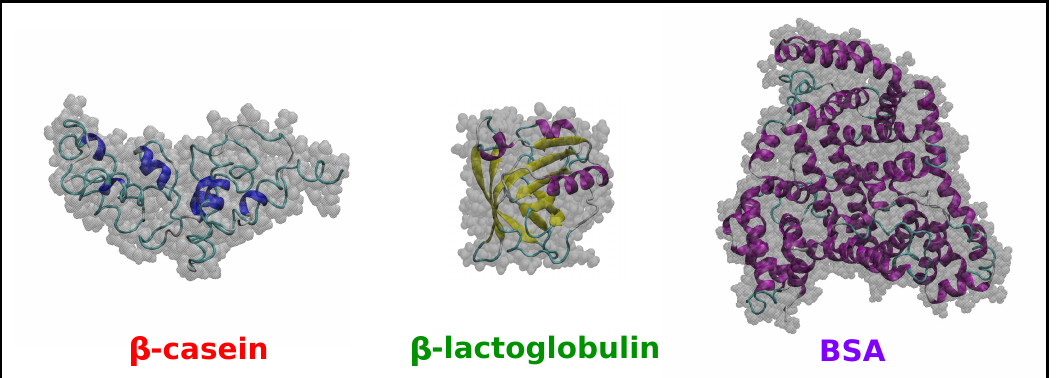
Figure 3. Snapshots of β -casein, β -lactoglobulin and BSA in MD simulations at neutral pH and 298 K (see the text). The structure of the proteins is shown in cartoon representation, and the size of the protein is indicated in grey using a surface representation. These images were made with VMD